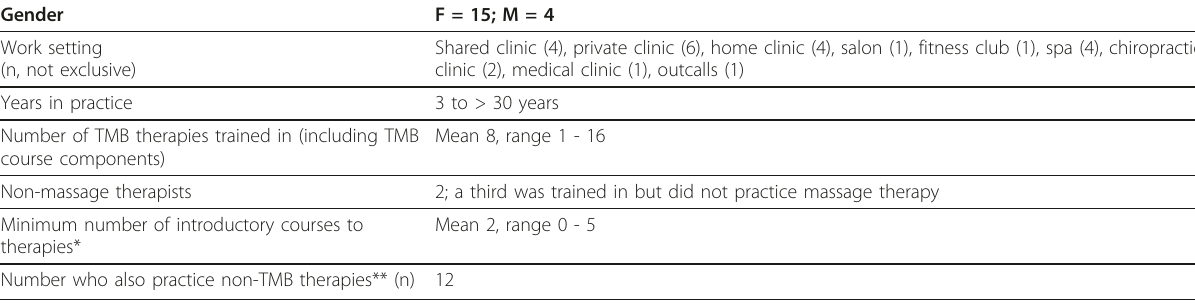
Table 5 Interview participant characteristics, including reported therapies trained in Gender F = 15; M = 4 Work setting (n, not